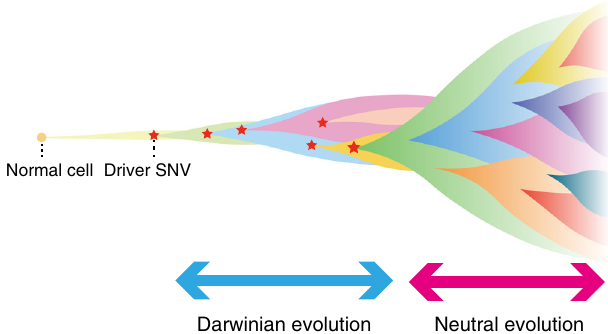
Fig. 5 Our model of colorectal cancer evolution. During early tumorigenesis, multiple subclones harboring heterogeneous mutations on different driver genes appear and constitute ITH by Darwinian evolution. The tumor is then confronted with growth limitation before progressing to the late phase of tumorigenesis. Out of the multiple subclones generated by Darwinian evolution, the parental clone that can conquer the growth limitation emerges. In addition to a suf fi cient set of driver single-nucleotide mutations, such a clone possibly acquires driver CNAs. The parental clone is selected to progress locally advanced cancer or metastatic cancer. During the late phase, extensive ITH is generated by neutral